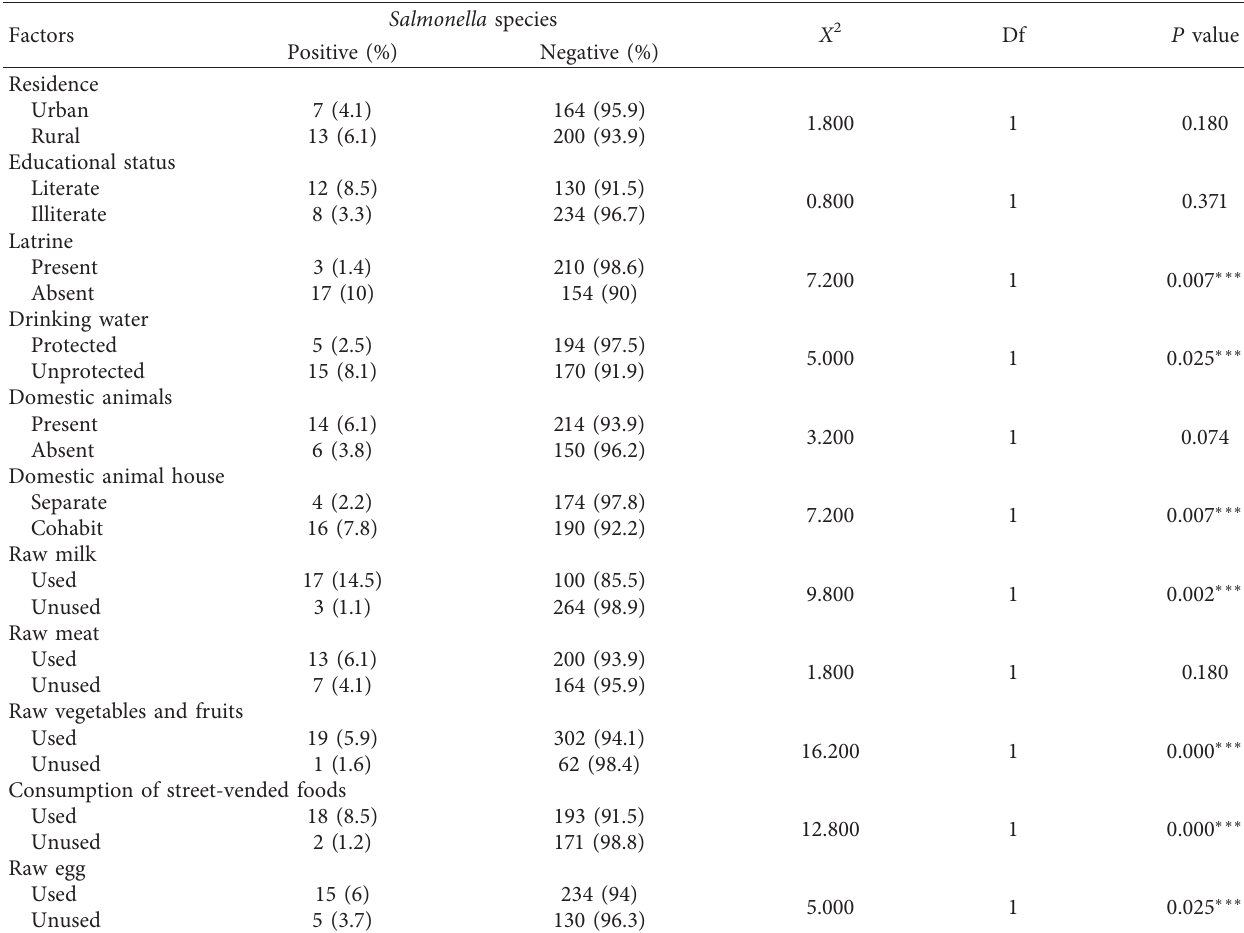
Table 2: Prevalence of Salmonella spp. and associated risk factors in the study area in 2016/17.